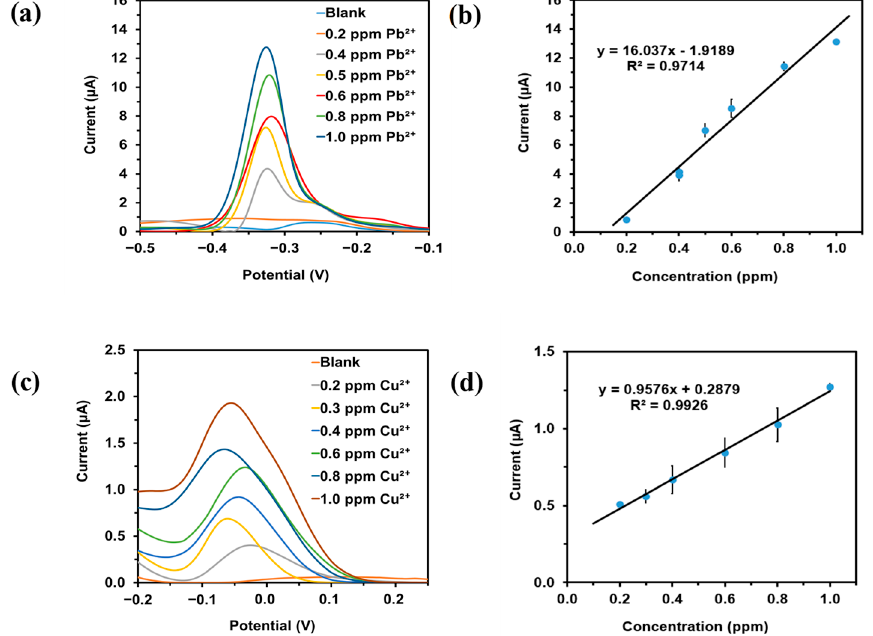
Figure 7. The DPV response of the TC4/AuNPs/SPCE toward ( a ) lead ions (Pb 2+ ) and ( c ) copper ions (Cu 2+ ). The calibration curve of ( b ) lead ions (Pb 2+ ) and ( d ) copper ions (Cu 2+ ).